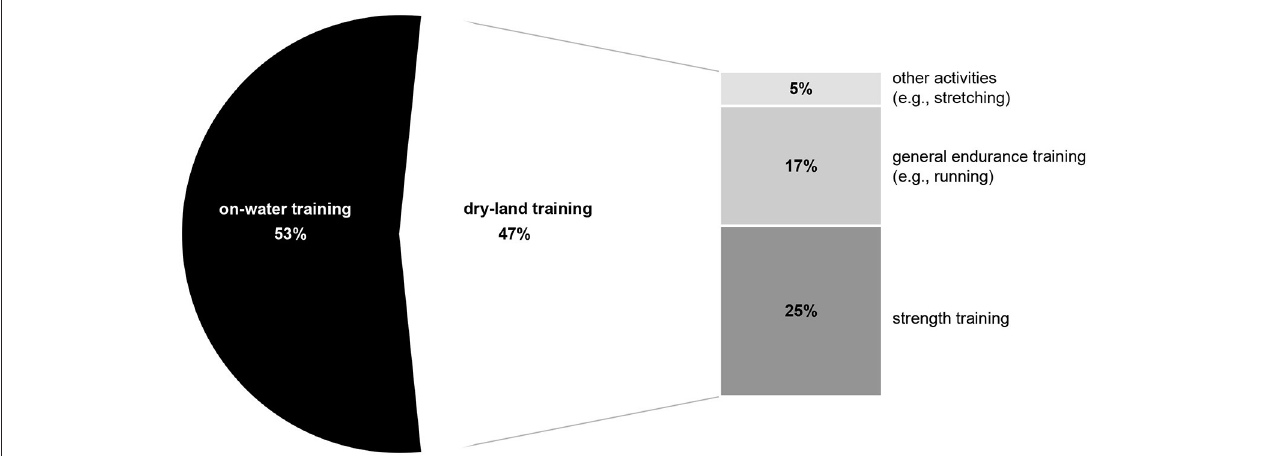
FIGURE 2 | Overall distribution of the different aspects of training during the period of